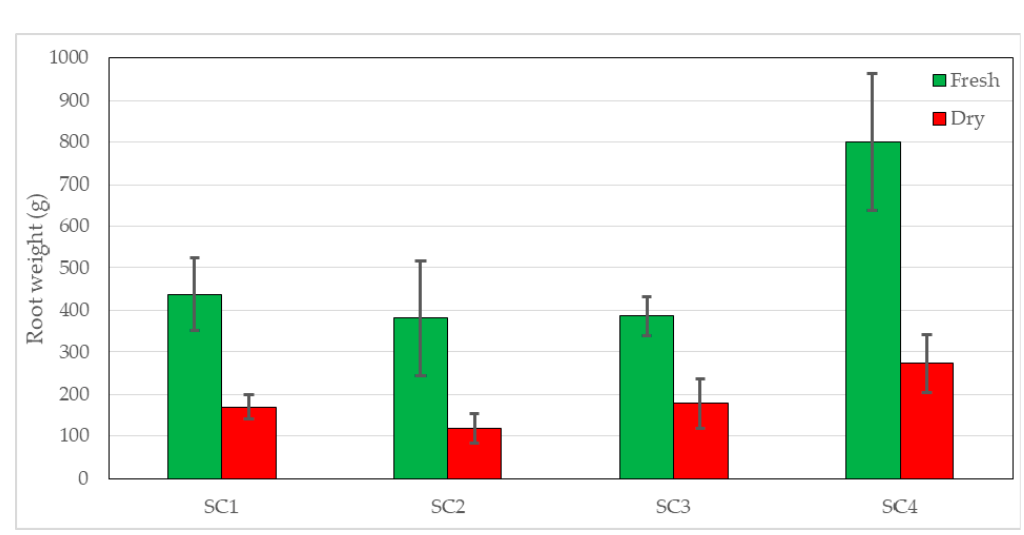
Figure 9. Mean values of fresh and dry root weight (expressed as g/potted plant) related to the four Substrate Compositions (SC). The bars stand for standard deviation values ( n = 4).